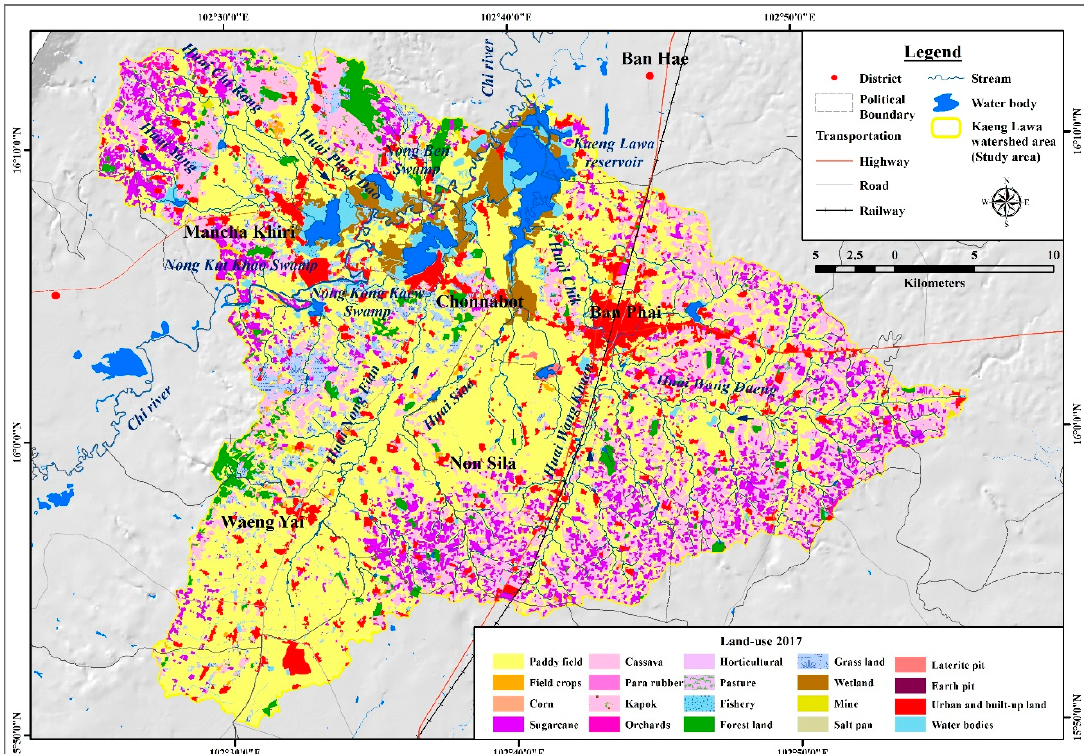
Figure 7. Land-use patterns in 2017 of KLs area, Khon Kaen Province.